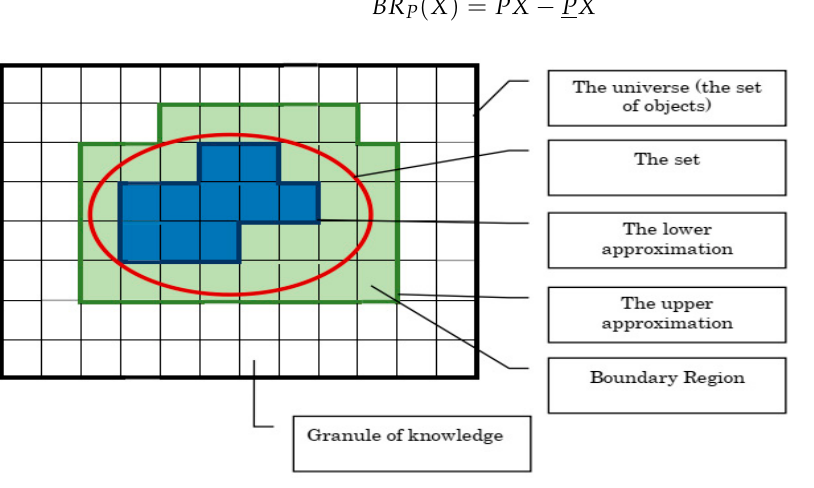
Figure 1. Representation of approximation sets.